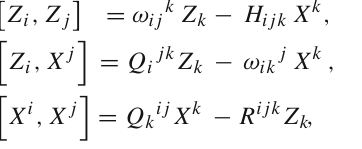
Table 3 Bianchi identities of the first formulation and their counting Class Bianchi Identities of the First formulation Maximum no.